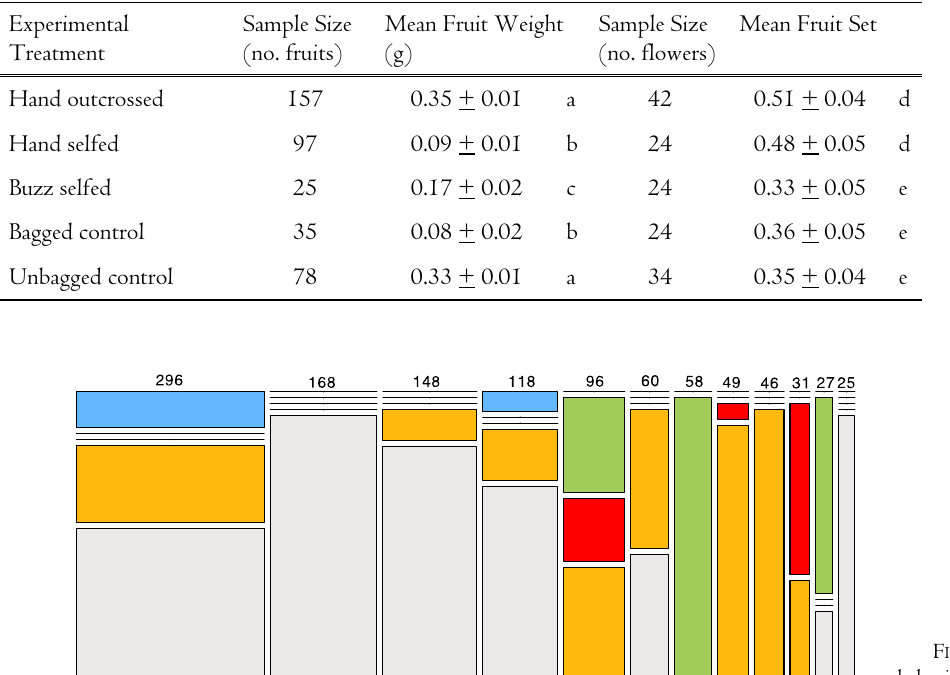
F IGURE 1. Mosaic plot of foraging behaviours of the 12 most common visitors to Arctostaphylos pungens , indicating that most flower visitors employed more than one foraging strategy. Visitors are arranged from left to right according to abundance, and sample sizes are given above each bar.